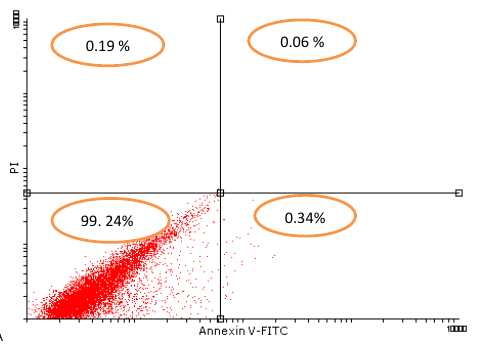
Figure 4. Flow cytometry graph of annexin/pi for EDTA treated SCAPs: (A) control group, (B) after 1 minute, (C) after 5 minutes, (D) after 10 minutes. In this graph, the upper left (annexin -/ pi +) indicates the necrotic cells, the lower left (annexin -/ pi -) indicates the viable cells, the upper right (annexin +/ pi +) indicates the late apoptotic cells, and the lower right (annexin +/ pi -) indicates the early apoptotic